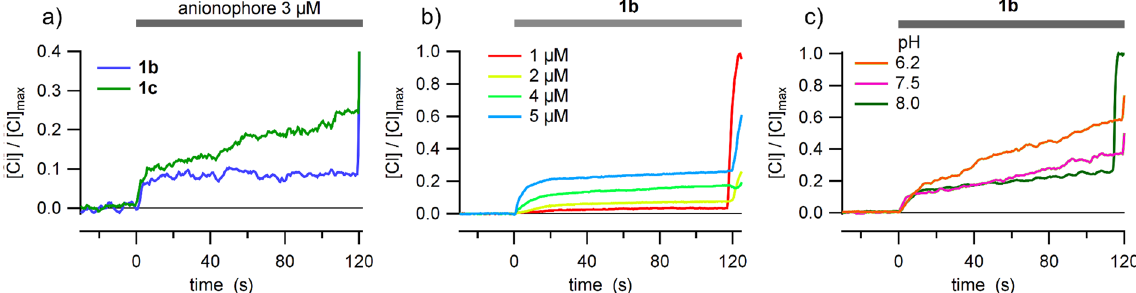
Figure 6. Anionophore-induced chloride efflux in HEK-293 cells. ( a ) Chloride efflux evoked by the application of 3 µ M of 1b and 1c , as indicated in the graphic. ( b ) Chloride efflux upon application of different concentrations of 1b . ( c ) Anionophore-induced chloride efflux measured at different extracellular pH, as indicated in the figure. Extracellular solution was 136 mM NaNO 3 , 3 mM KNO 3 , 2 mM Ca(NO 3 ) 2 , 20 mM HEPES, 11 mM Glucose, pH 7.4, except for ( c ), where pH was adjusted as